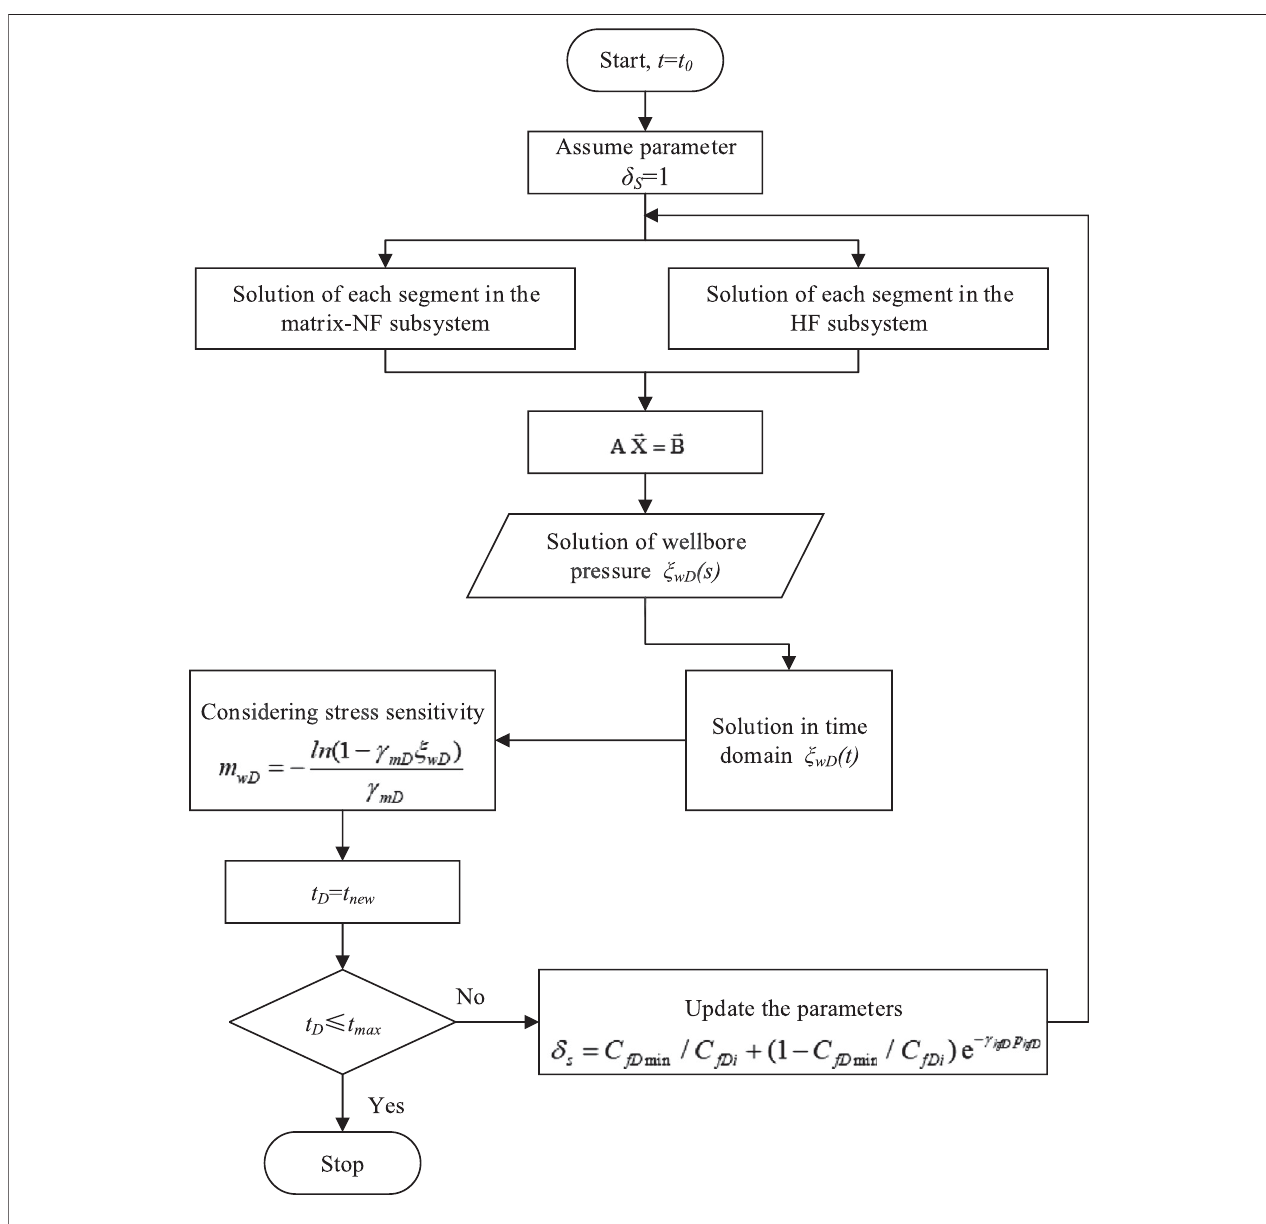
FIGURE 3 | Flowchart for evaluating the performance of a multi-well pad with multiple fractures.